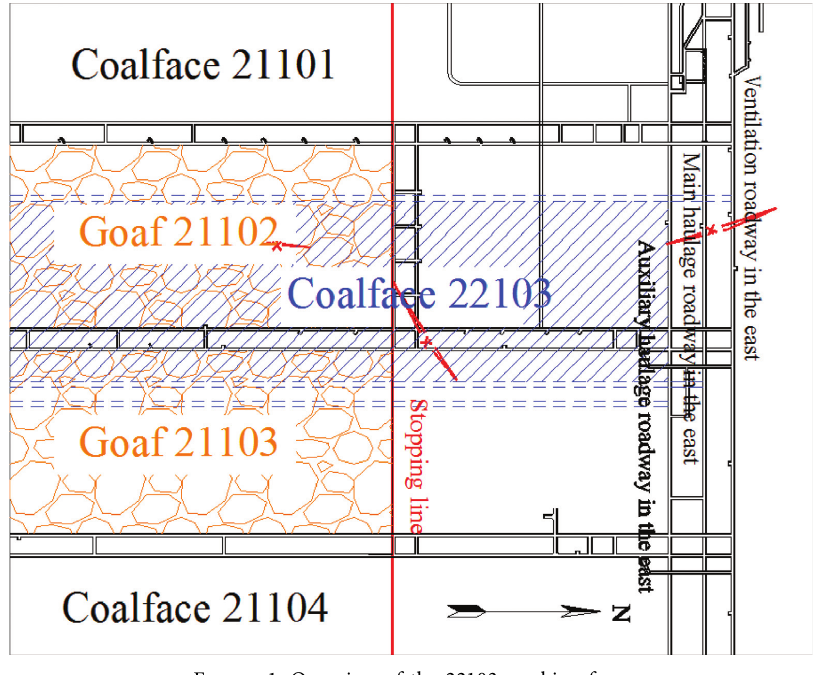
Figure 1: Overview of the 22103 working face.